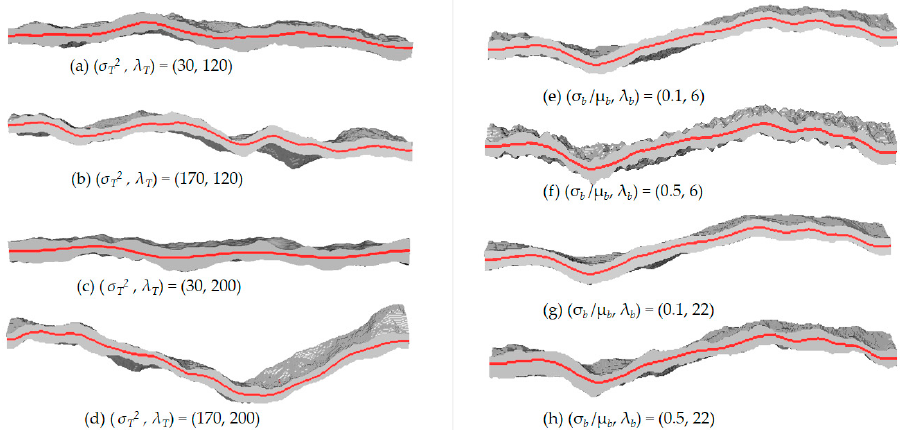
Figure 13. Illustration of the accumulated influence: four fracture models of (a–d) for various σ T2 and λ T with the same ( μ b , σ b / μ b , λ b ) = (13, 0.5, 22); four fracture models of ( e–h ) for various σ b / μ b and λ b with the same ( μ b , σ T2 , λ T ) = (13, 100, 120). The red curve represents the trend surfaces.